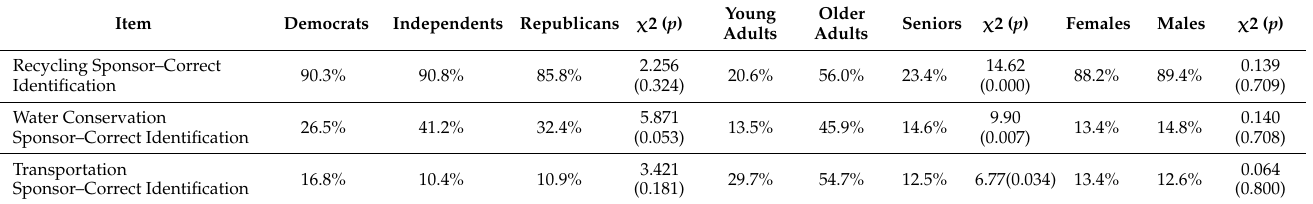
Table 4. Chi-Square Table Examining Identification of Sponsors for Each Sustainability Initiative.